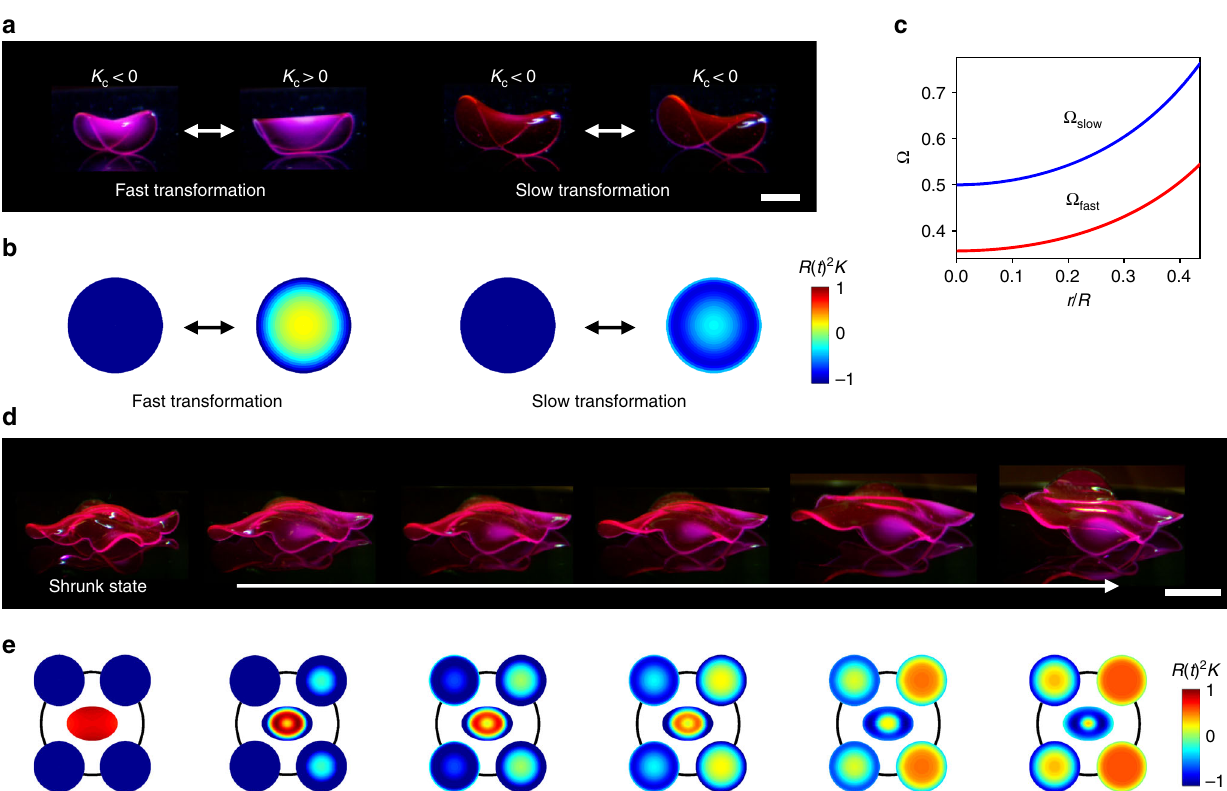
Fig. 6 Dynamic 3D structures with programmed sequential motions. a Fast and slowly transforming saddle structures at t = 0 (left) and 30 min (right) during cooling. K c is K in the center of structures. b Theoretically calculated K of the structures in a . R ( t ) 2 K is normalized K using the time-dependent R as described in Supplementary Figure 21. c Growth functions used to create the saddle structures with different speeds of shape transformation in a . The red and blue lines represent Ω fast and Ω slow used to create the fast and slowly transforming structures in a , respectively. d Ray-inspired 3D structure with programmed sequential motions. The images show the structure at the equilibrium shrunk state and the dynamic structures at 0, 5, 10, 20 and 25 min during cooling of a temperature cycle (from left to right). e Theoretically calculated dynamic K maps of the modules in the structures in d at the equilibrium shrunk state and at 0, 5, 10, 20 and 25 min during cooling (from left to right). Scale bars, 2 mm in a ; 5 mm in